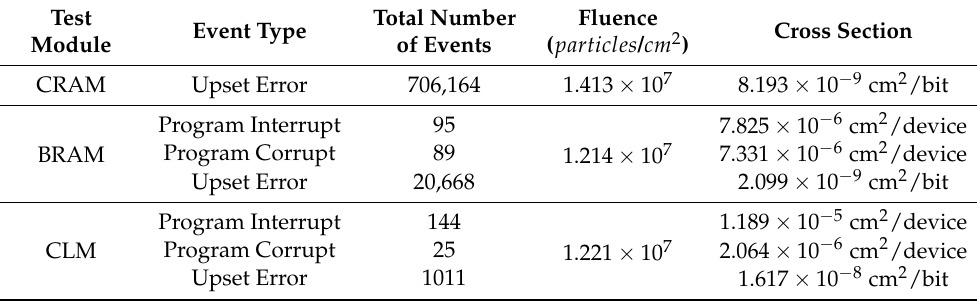
Table 4. The experiment results for the PGL22G